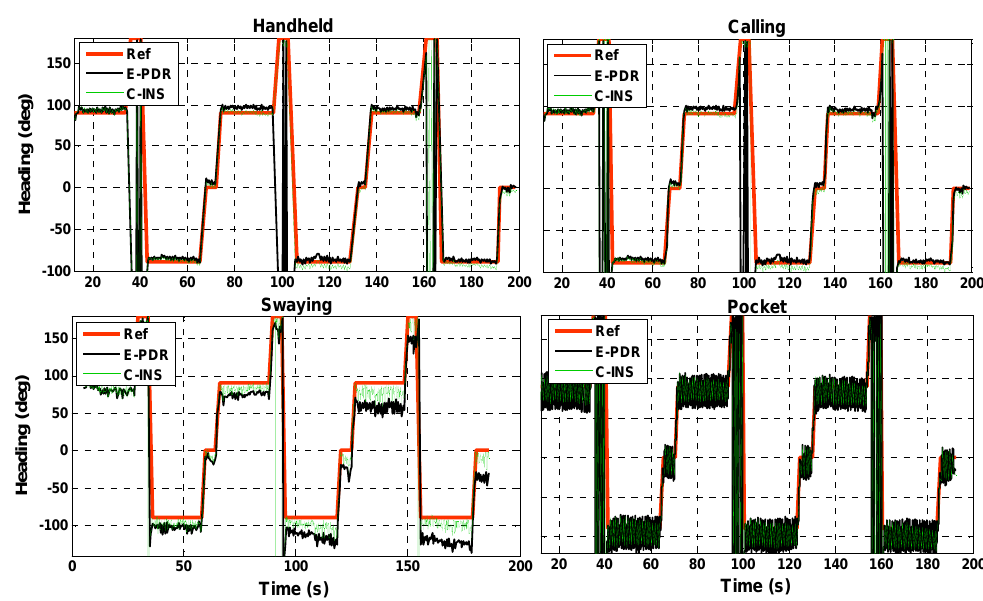
Figure 6. Heading of reference, E ‐ PDR, and C ‐ INS solutions for four different phone ‐ holding positions.